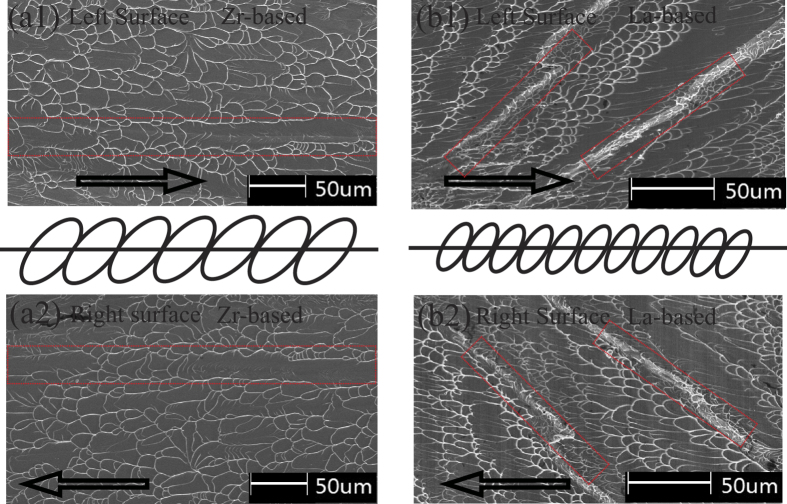
Fracture morphologies on the two corresponding fracture surfaces in the same sites for an identical specimen.(a) Zr52.5Cu17.9Ni14.6Al10Ti5. (b) La60Ni15Al25.